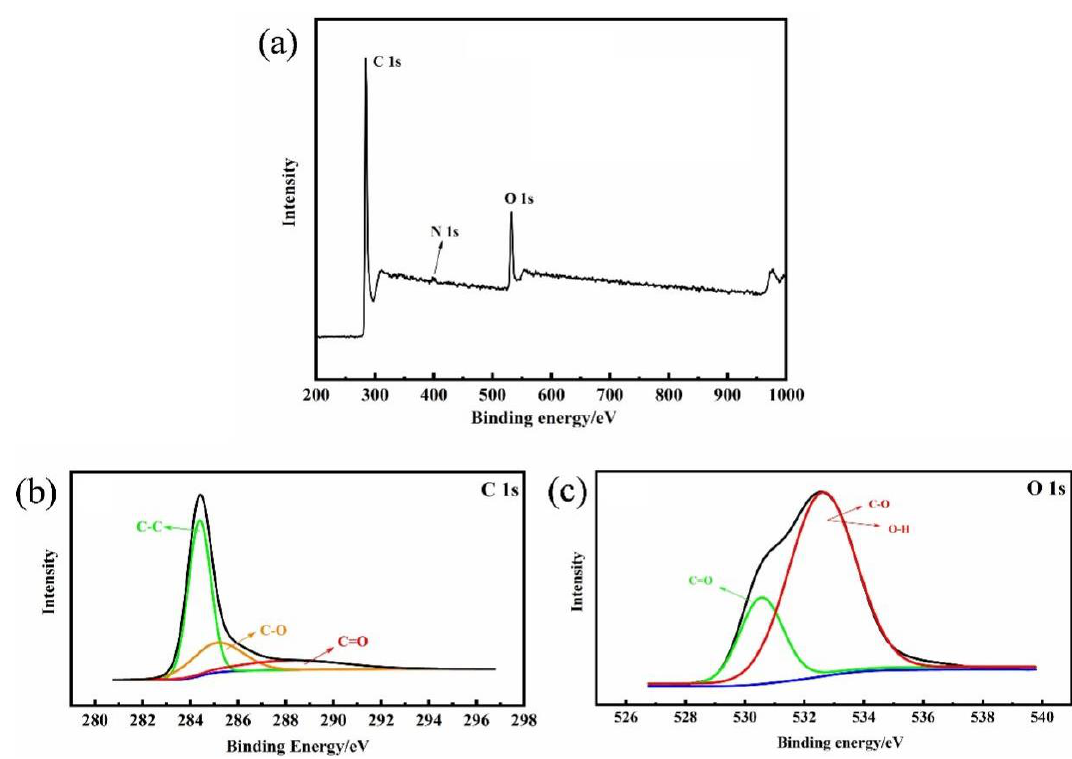
Figure 4. ( a ) XPS pattern of EC-400; ( b ) high resolution C 1s; and ( c ) O 1s.